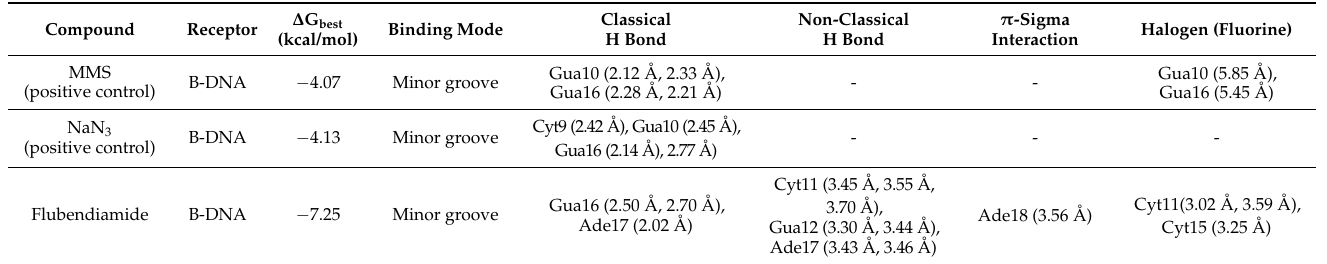
Table 2. Docking binding free energies, binding mode and DNA nucleotide-interaction results,